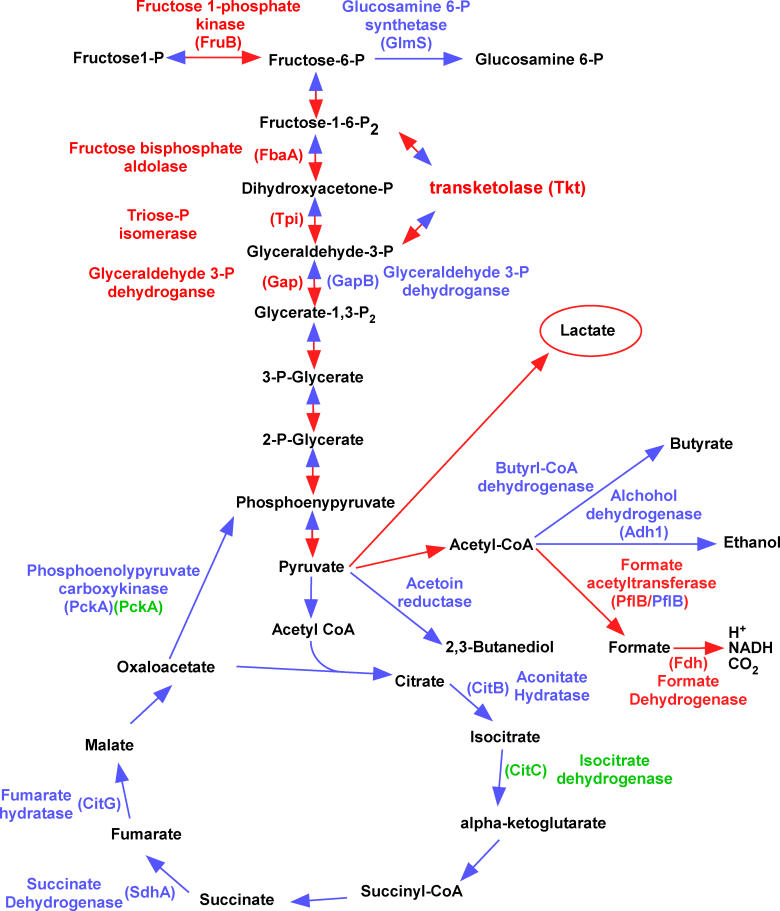
Lactate Is a Primary End-Product of Carbohydrate Metabolism by Iron-Starved S. aureus
A subset of the predicted central metabolic reactions of S. aureus is shown. Proteins shown in red are up-regulated in the absence of iron or upon inactivation of fur. Proteins shown in blue are down-regulated in the absence of iron or upon inactivation of fur. Proteins shown in green are down-regulated in the absence of Fur independent of iron status. The red arrows predict the direction of reactions upon iron starvation, while the blue arrows predict reactions that are inhibited upon iron starvation.